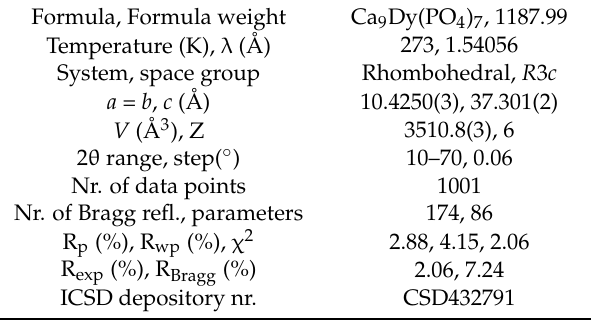
Table 2. Crystal data, structure refinement parameters and ICSD [70] depository number for Ca 9 Dy(PO 4 ) 7 [64].